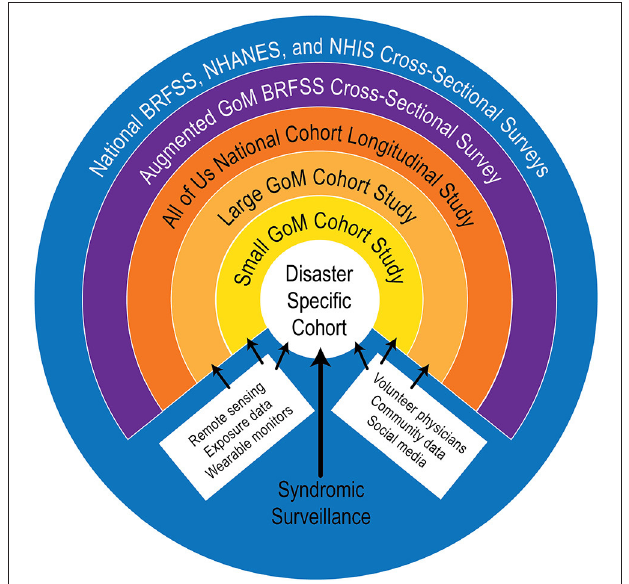
FIGURE 1 | Schematic framework for a Gulf of Mexico Community Health Observing System [from Sandifer et al. ( 33)].